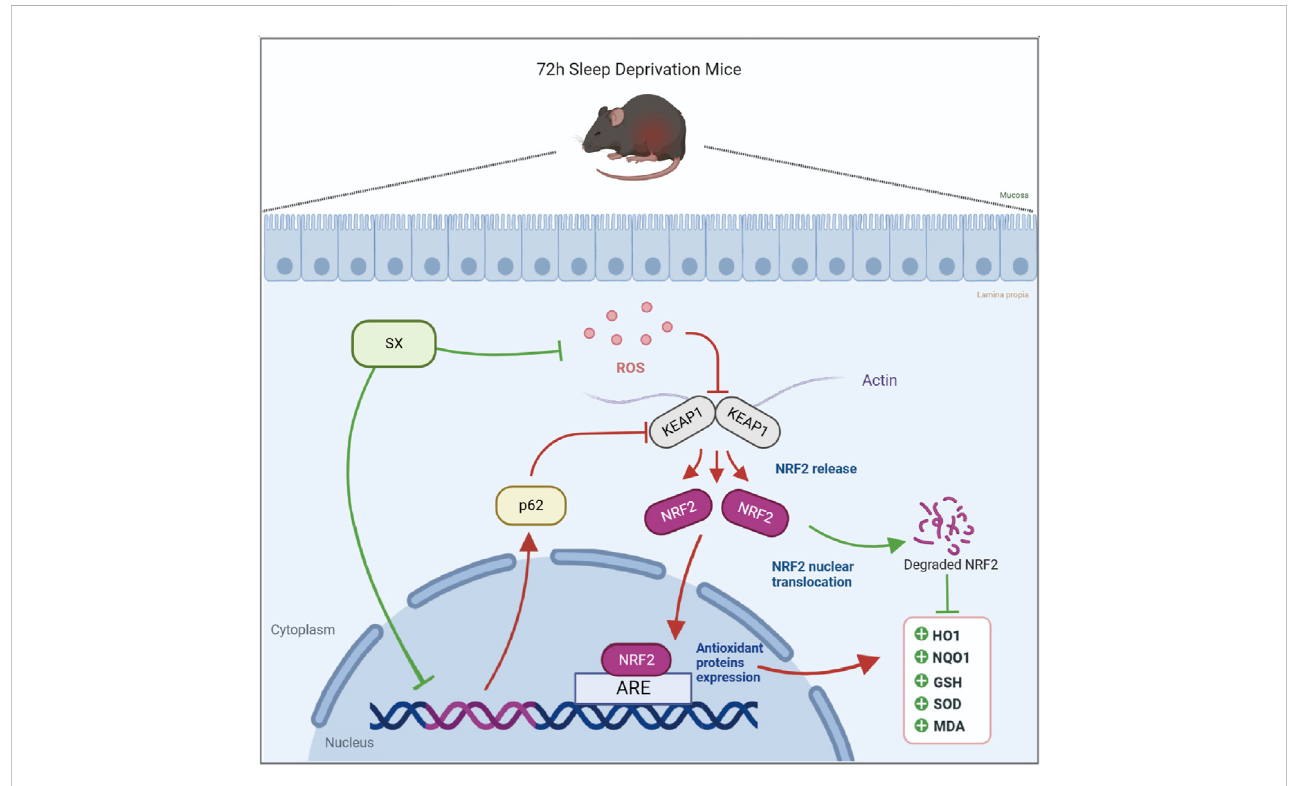
Diagrammatic representation shows the mechanism by which SX alleviates ASD-induced oxidative stress and colon